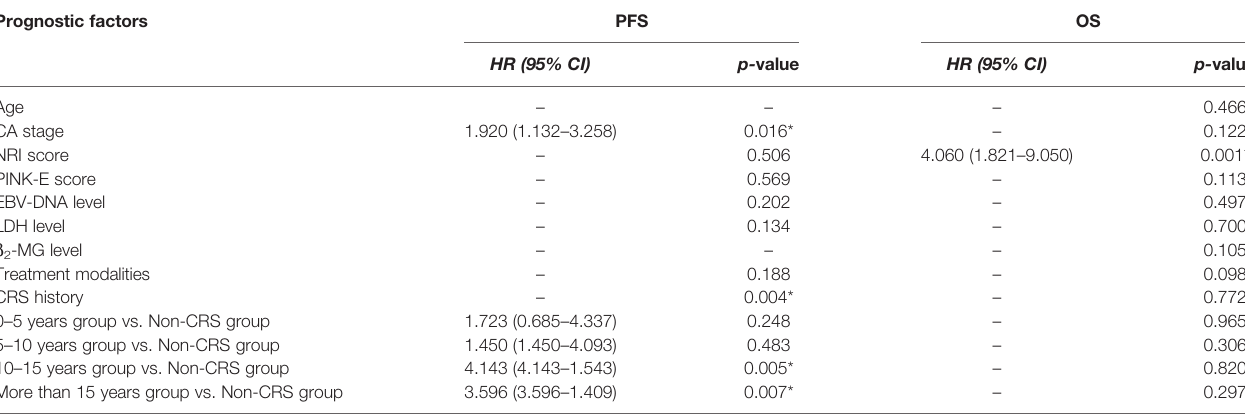
TABLE 5 | Multivariate analysis of prognostic factors for PFS and OS. Prognostic